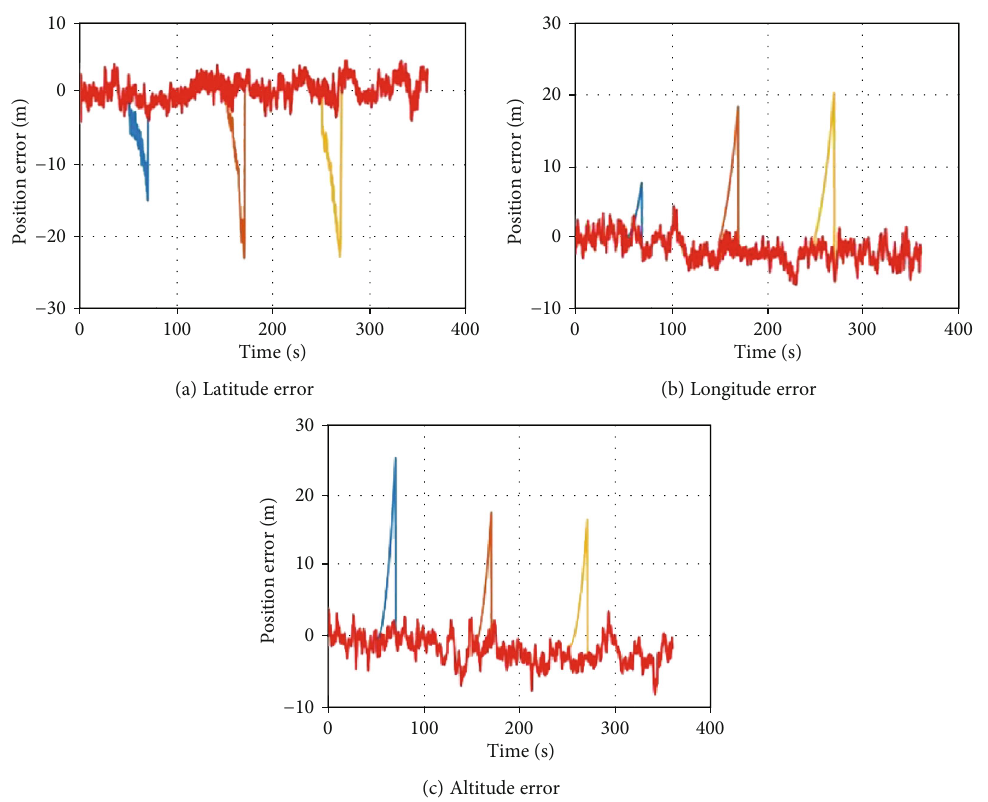
Figure 10: Position errors (no available satellites during a signal